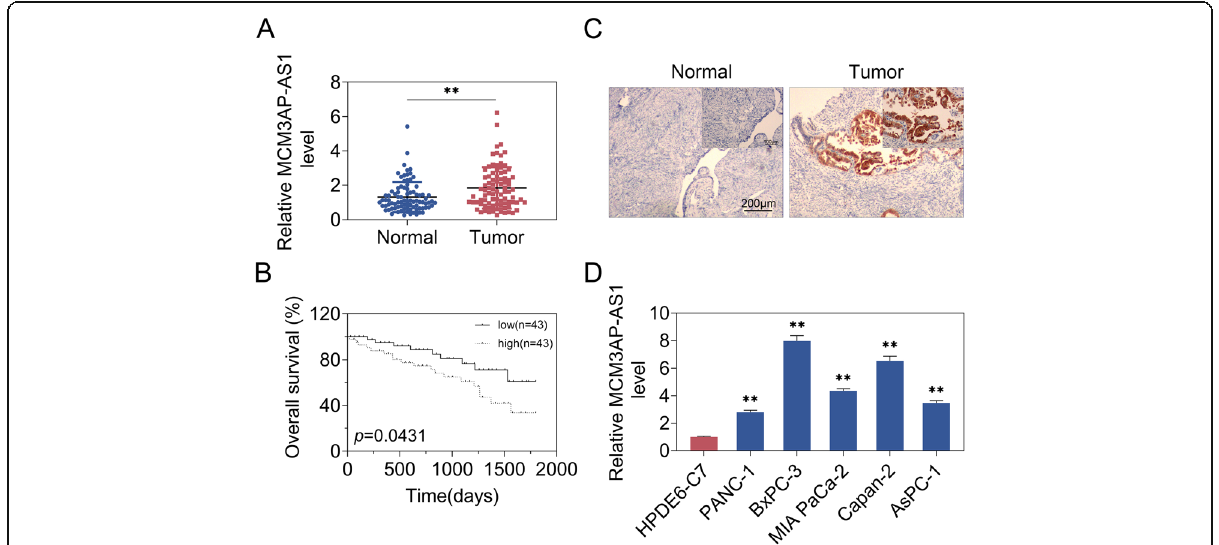
Fig. 1 MCM3AP-AS1 was up-regulated in PC. a qRT-PCR measured MCM3AP-AS1 level in n PC tissues and adjacent normal tissues. n = 86. b Overall survival was analyzed. n = 86. c ISH detected MCM3AP-AS1 expression. Scale bar, 50 μ m. d MCM3AP-AS1 level was examined using quantitative real time PCR in PC cell lines and pancreatic duct epithelial cells. n = 3. (**, p <